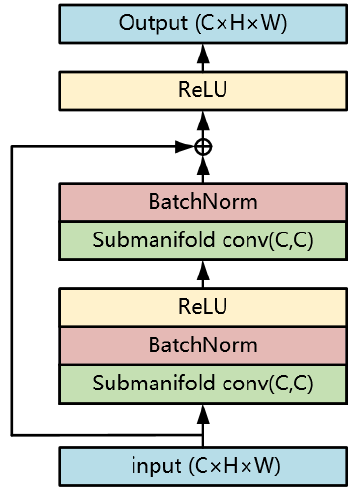
Figure 4. Submanifold convolutional of Centerpoint-FE.